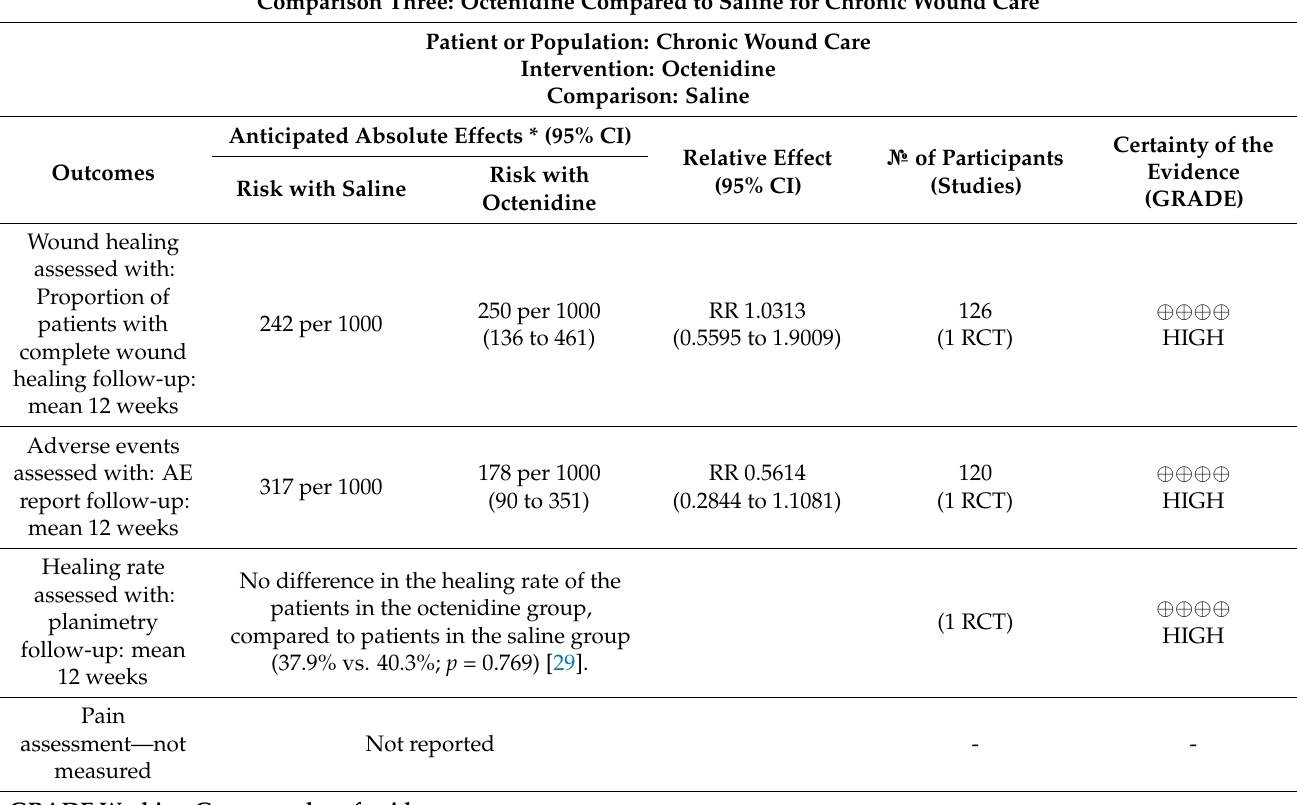
Table 4. Summary of findings table with comparison between octenidine and saline solution in chronic wound